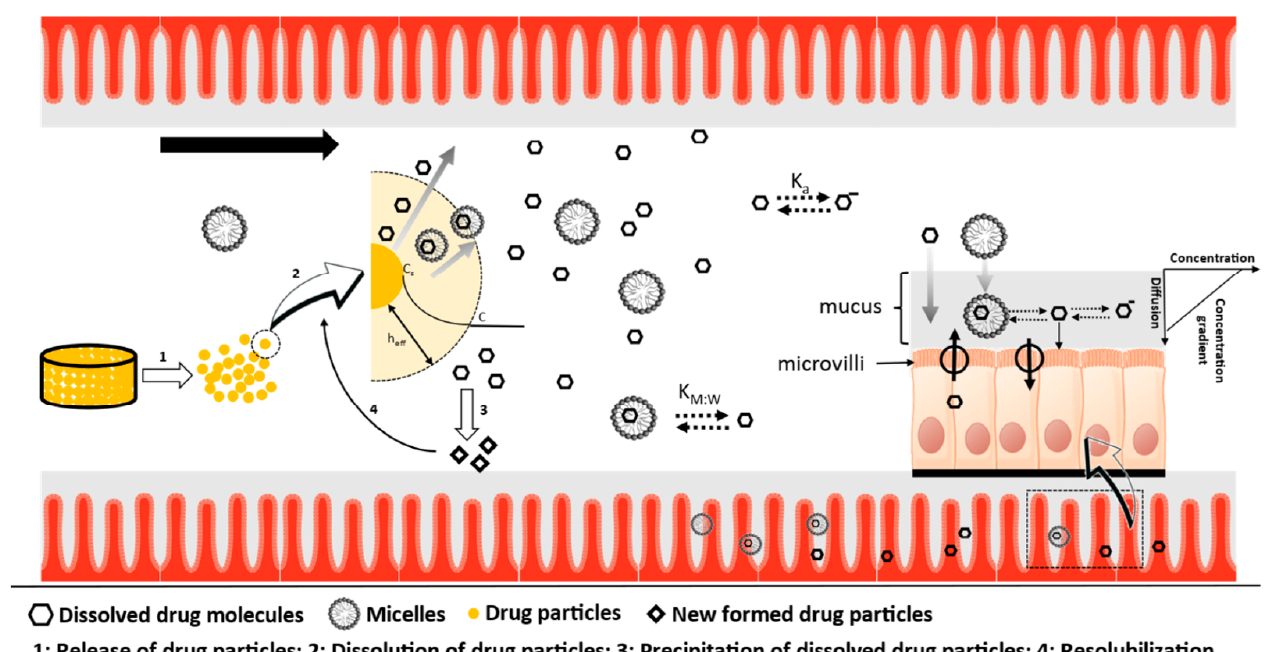
Figure 6. Schematic representation of the phenomena that take place in the luminal environment of the human GI tract affecting the performance of the dosage form and the absorption of the drug molecules; Ka ionization constant; K M:W : micelle-to-water partition coefficient; Cs: drug concentra- tion at the surface of the drug particle; C: bulk concentration of the drug.